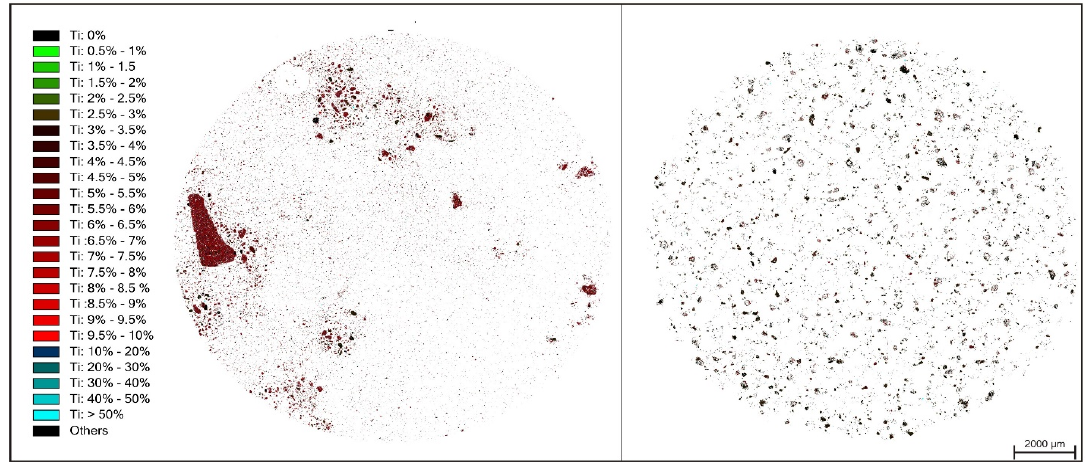
Figure 3. Ti elemental mapping of red mud (left) and H 2 SO 4 leach residue (right) by QEMSCAN analyses.